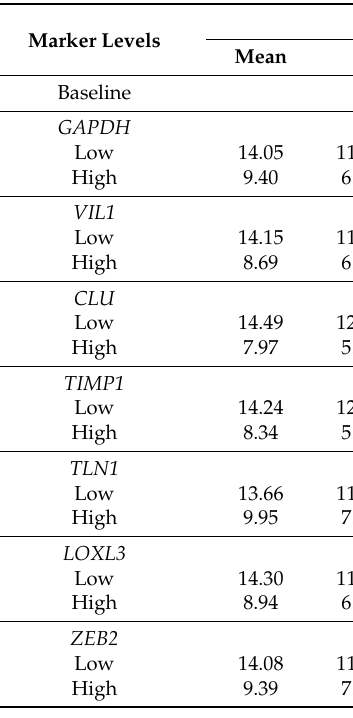
Table 1. Kaplan-Meier survival analysis of progression-free survival (PFS) and overall survival (OS), according to the expression of individual CTCs markers below (Low) or above (High) the cutoff at baseline and at four weeks